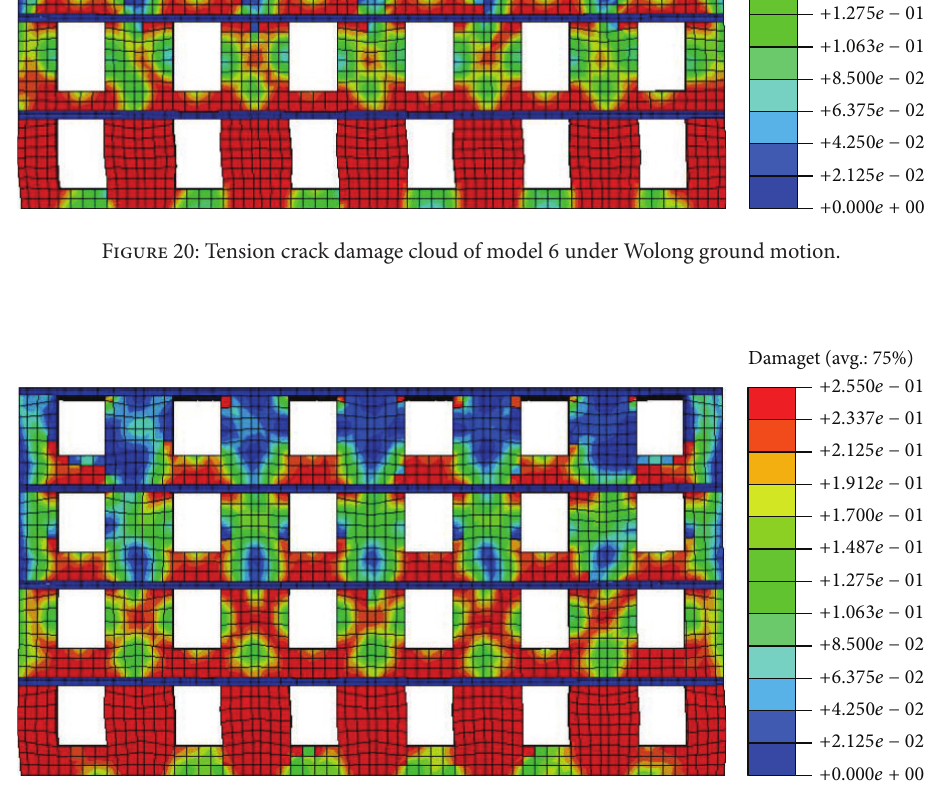
Figure 21: Tension crack damage cloud of model 2 under Wolong ground motion.